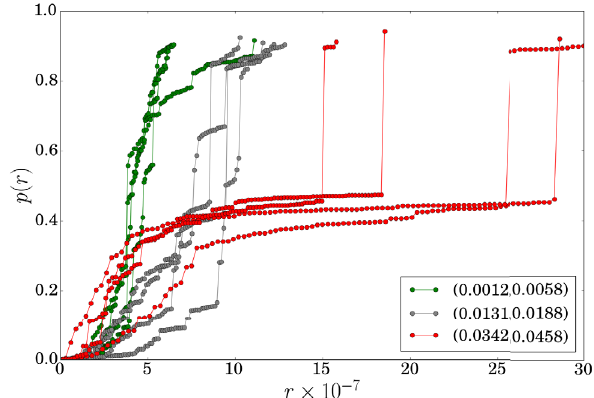
Figure 6. Evolution of p ( r ) versus r in the lead up to and during the limit